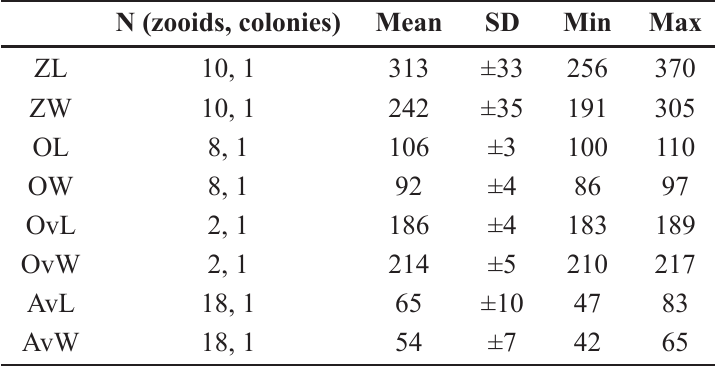
Table 3. Measurements in microns of Parkermavella columnaris sp. nov., Castlecliffian, Pleistocene, Upper Kai-Iwi